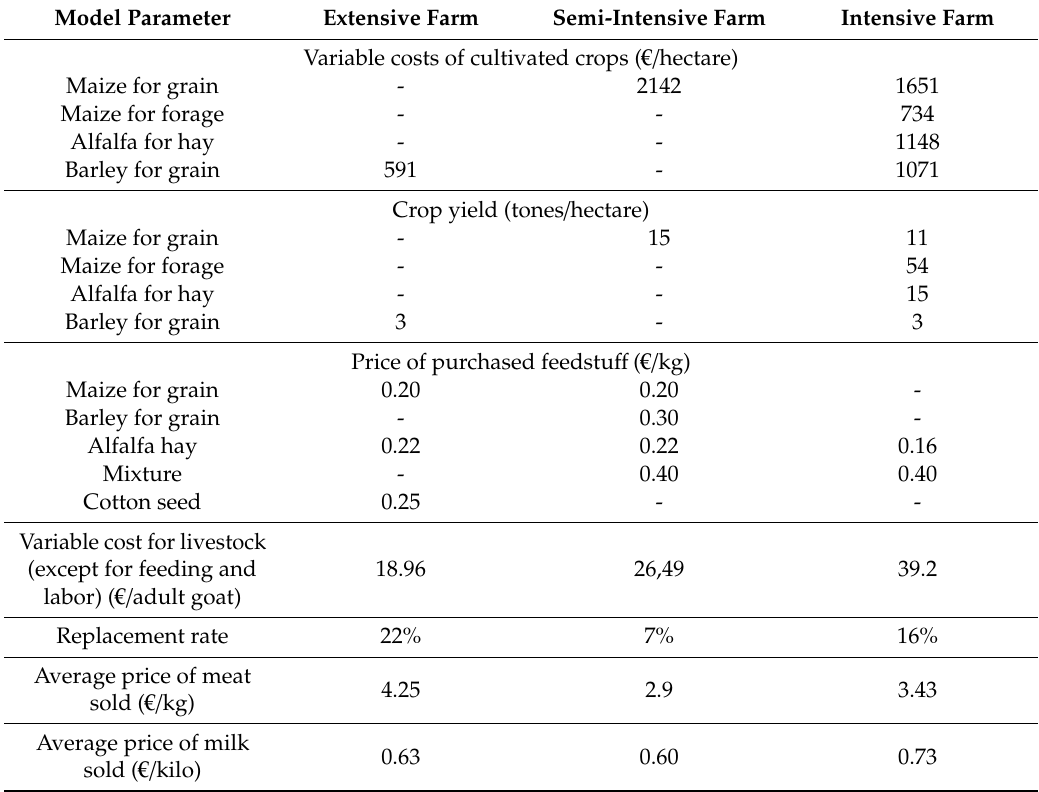
Table 5. Main parameters used in the linear programming (LP)